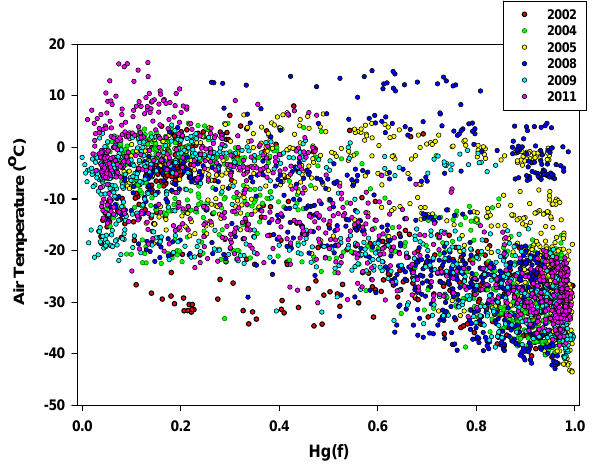
Fig. 4. Linear regression of air temperature vs. particulate Hg frac- tion for March to June time period (ratio Hg(f) = [PHg]/([PHg] + [RGM])). Slopes: 2002: − 27.7; 2004: − 29.4; 2005: − 29.4; 2008: − 16.5; 2009: − 26.7; 2011: − 32.4 R 2 values: 2002: 0.56; 2004: 0.64; 2005:0.45; 2008: 0.12; 2009: 0.58; 2011: 0.72. Years 2003, 2006, 2007 and 2010 are not included due to large data gaps.